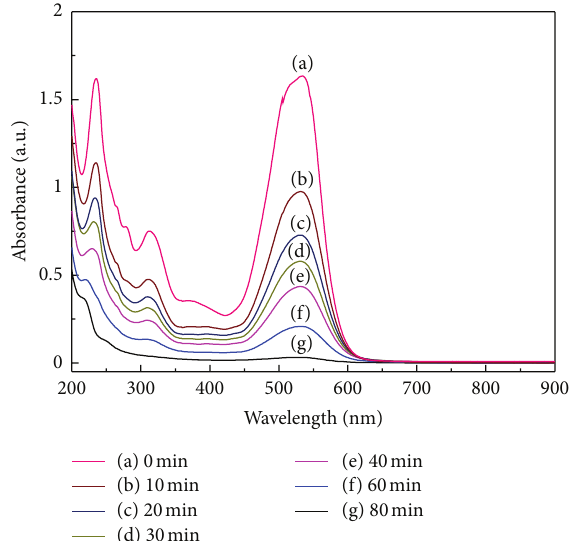
Figure 4: UV-vis spectra of X-3B solution as a function of wavelength for various time intervals.